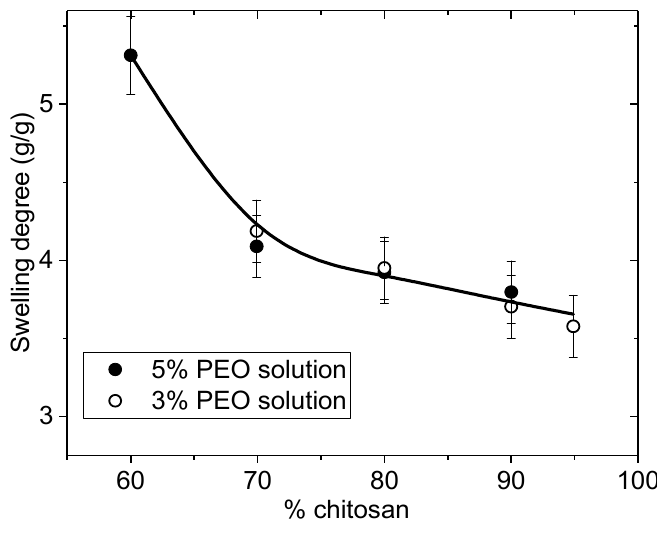
Figure 6. Degree of swelling of nanofiber mats after extraction of PEO ( M W = 5 × 10 6 ) and rehydration as a function of the initial chitosan content w / w % in the initial blend.